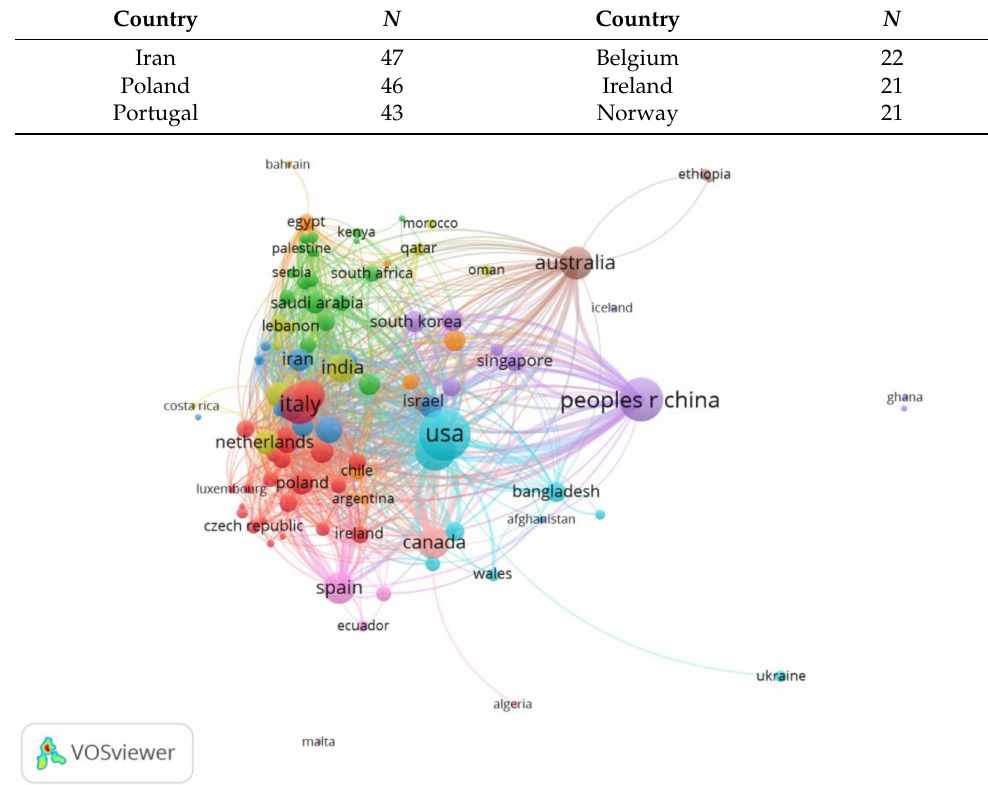
Figure 4. Network map of country collaboration